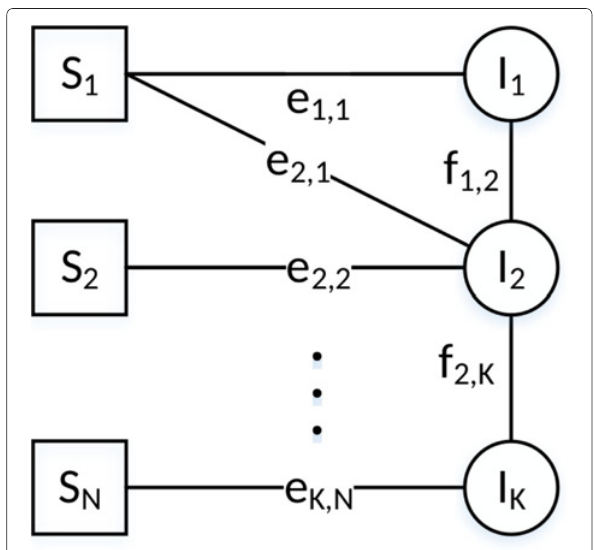
Fig. 8 Graph model of slice instances and service instances described in [89]. Image based on [89]